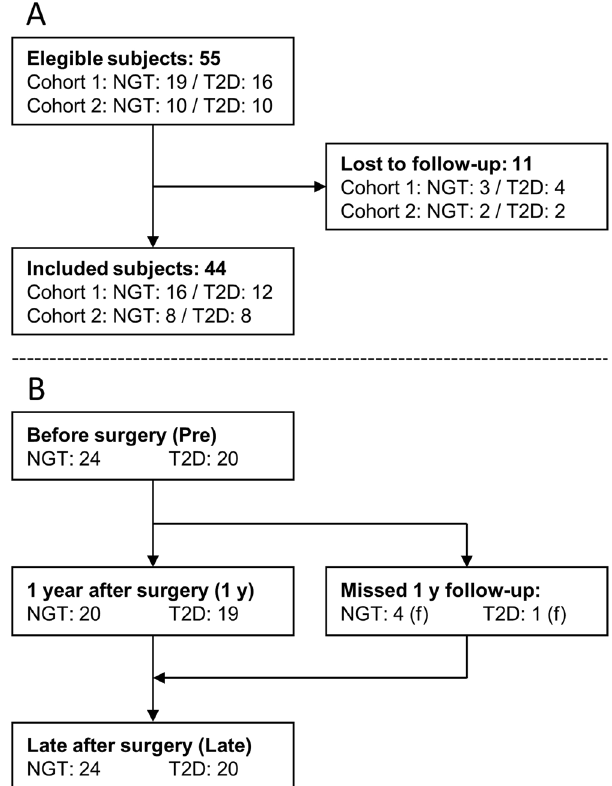
Figure 1. ( A ) Flow chart illustrating the inclusion of patients. ( B ) Flow of included patients in the